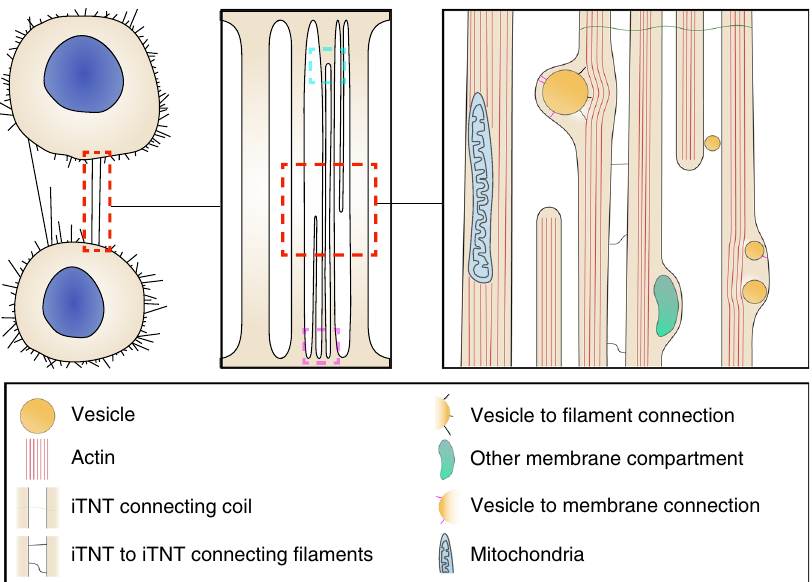
Fig. 8 Schematic diagram depicting how cells connect via TNTs. TNT-connecting cells can either be single thick connections or a bundle of thin individual TNTs (iTNTs). iTNTs contain vesicles and mitochondria. Membranous compartments within iTNTs appear to be connected by thin fi laments to actin on one side and to the inner side of the plasma membrane on the other. Thin membrane threads coil between and around several iTNTs. Cyan and magenta dashed squares show two types of contact sites: merging of iTNTs prior to fusion and fusion of iTNTs at separate locations,